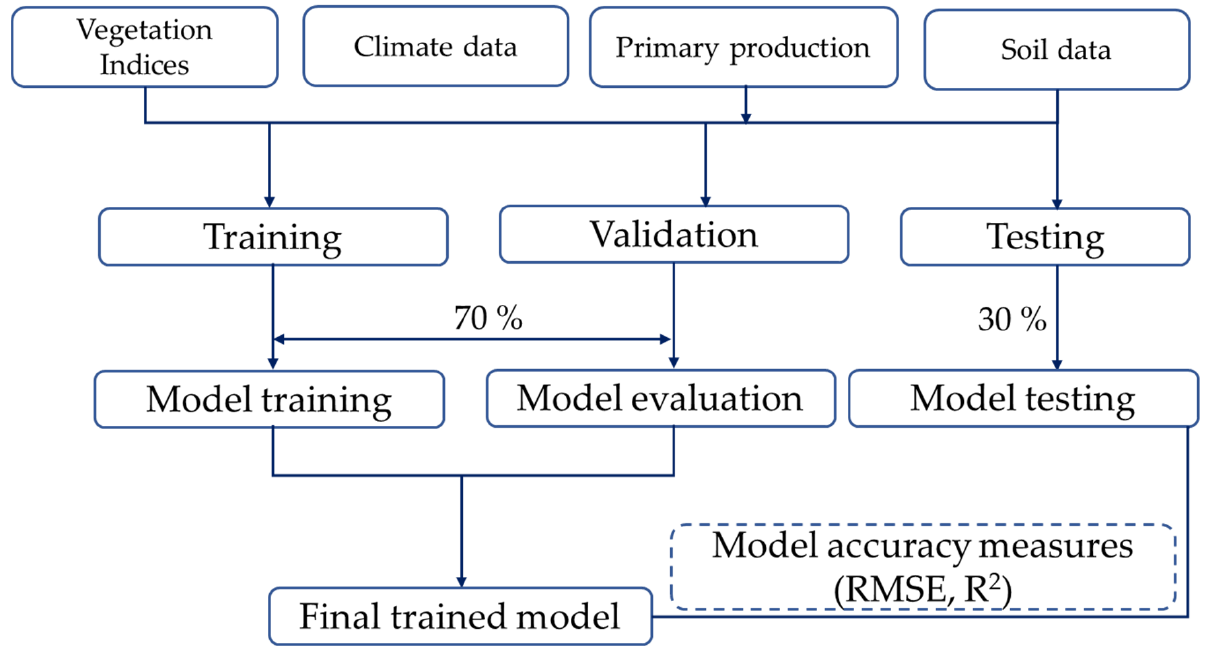
Figure 2. Experimental design.